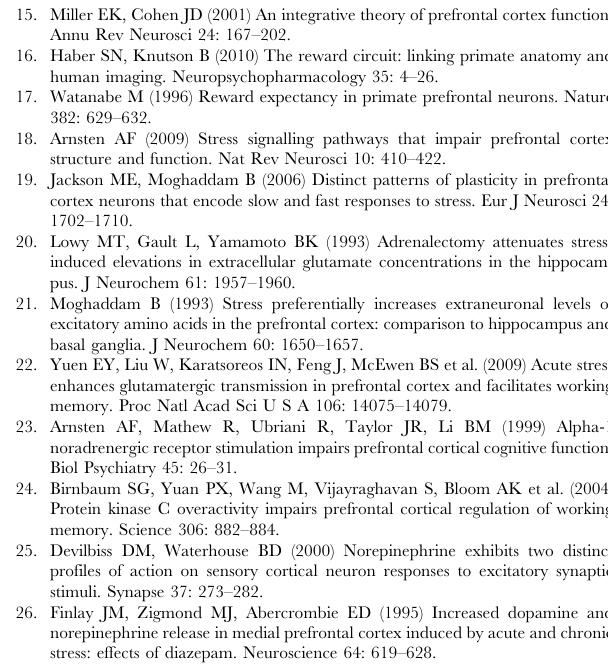
Figure S2 Action potential waveforms of 5 discriminated and validated pl PFC neurons and rejected electrical activity. Neuronal